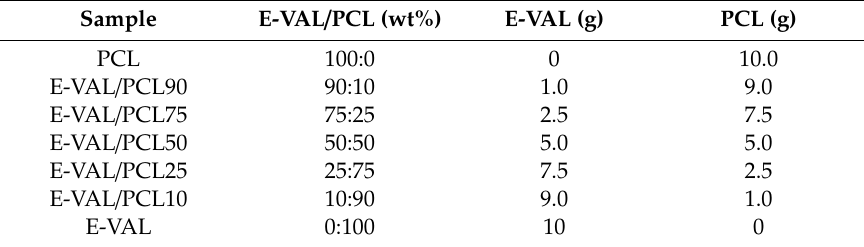
Table 6. Preparation of PCL / E-VAL blends in